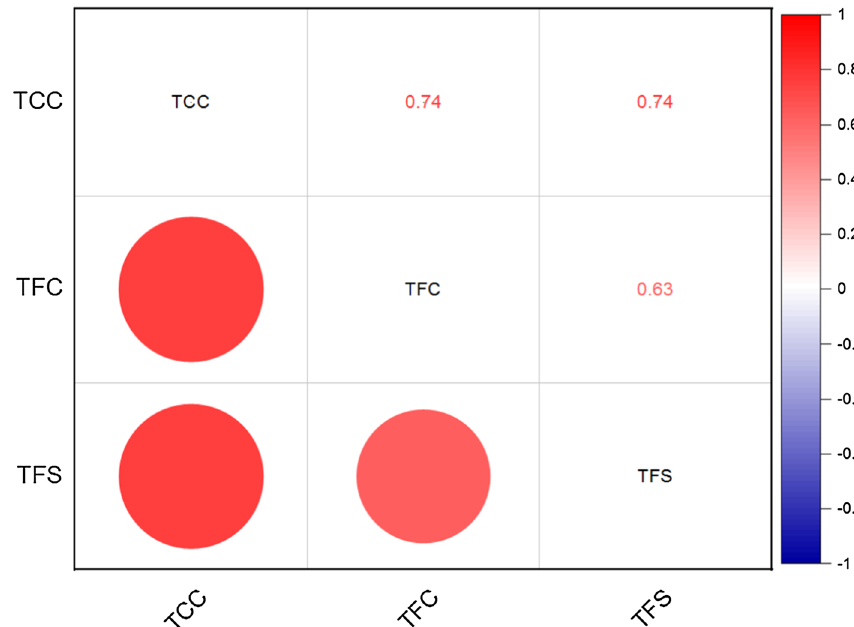
Fig. 7 Correlation among microbial parameters in Chu Tran Valley water